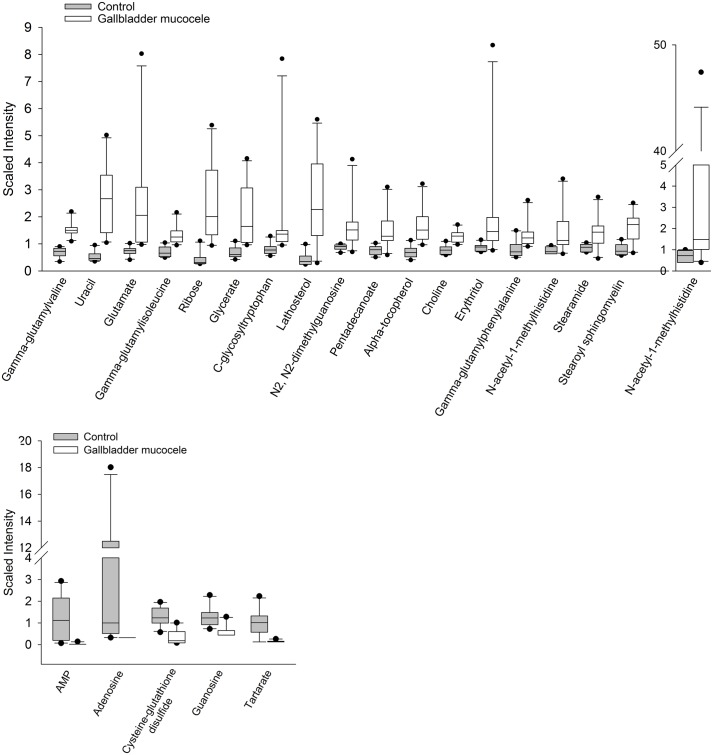
Selected serum metabolites with potential value as biomarkers of gallbladder mucocele formation.Each metabolite was identified by Random Forest analysis as important for classification of dogs into either control or gallbladder mucocele formation groups. Panel A demonstrates compounds observed to be significantly higher in the serum of dogs with mucocele formation. Panel B demonstrates compounds observed to be significantly lower in the serum of dogs with mucocele formation compared to control dogs. Data represent median, 25th to 75th percentile (box), 10th to 90th percentile (whiskers), and outlier data points.